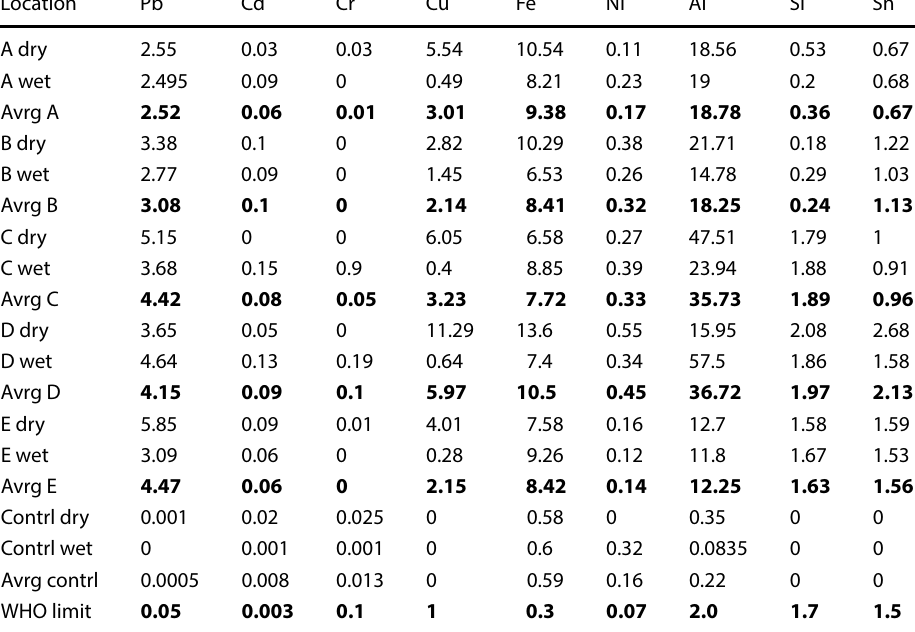
Table 2 Concentration of heavy metals (mg/L) in Lagos harbour